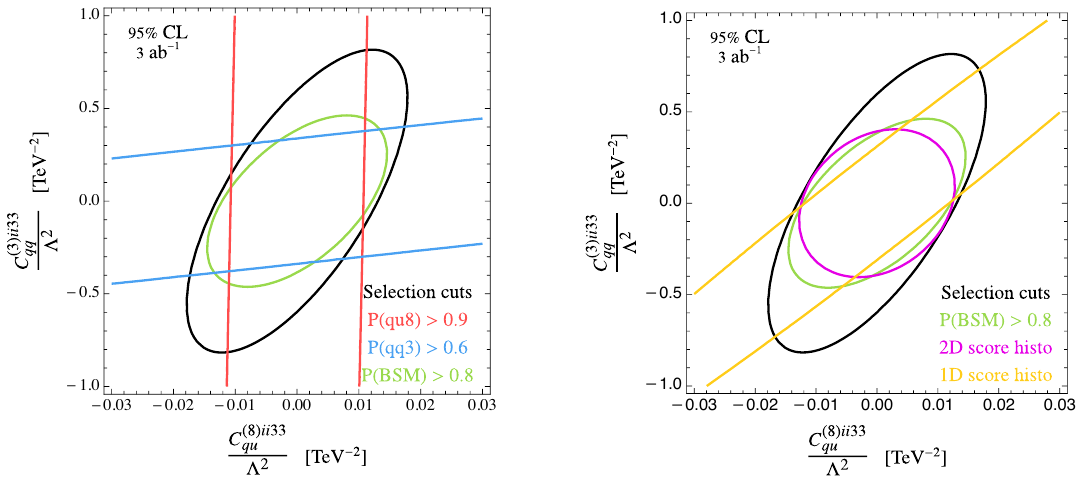
Figure 5 . WC constraint contours at the 95% C.L. from χ 2 fitting; in black from the data of the baseline selection of section 2 which also passes the network requirements. The left plot shows the contours from cuts on the NN scores at the optimal value of these score cuts, with the analysis performed using p T ( b 1 ) distributions. The right plot shows the BSM score cut as in the left plot, along with the contour from the 2D score histogram of figure 4 (with no score cuts) analysis, as well as an analysis using the 1D BSM score histogram. For details see